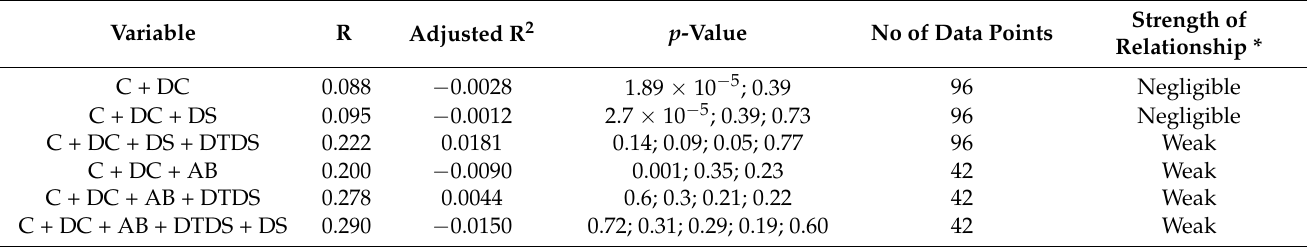
Table 6. Multivariable linear regression results for brine parameters.